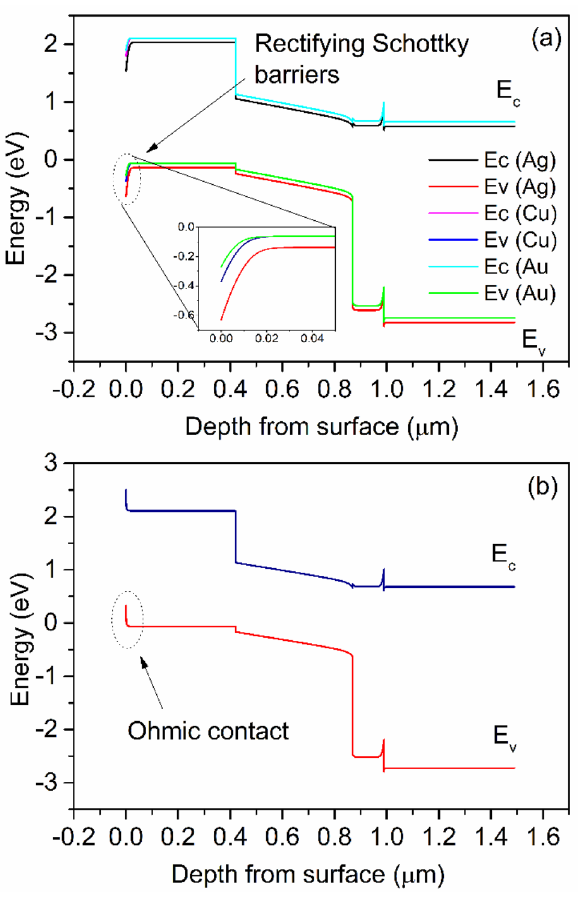
Figure 7. Band diagram of PSC with various anode materials ( a ) Ag, Cu, Au and ( b ) Pt.